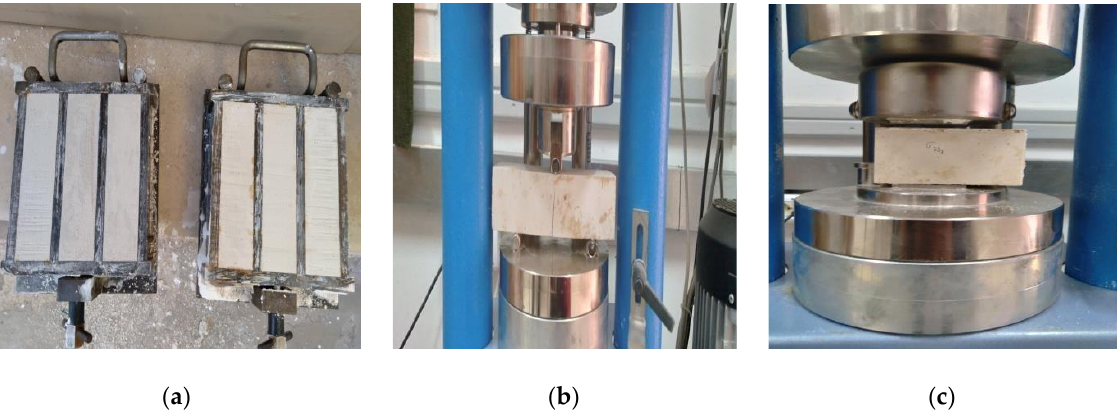
Figure 4. ( a ) Preparation of samples, ( b ) Flexural strength test, ( c ) Compressive strength test. Flexural strength (Rf):the sample was placed on two holders fixed at a distance of 10 cm between them. The load was applied in the middle of these two holders above the sample. A three-point bend test was performed until the test sample bisects (Figure 4). This test aimed to determine the maximum resistance of the specimen under bending.